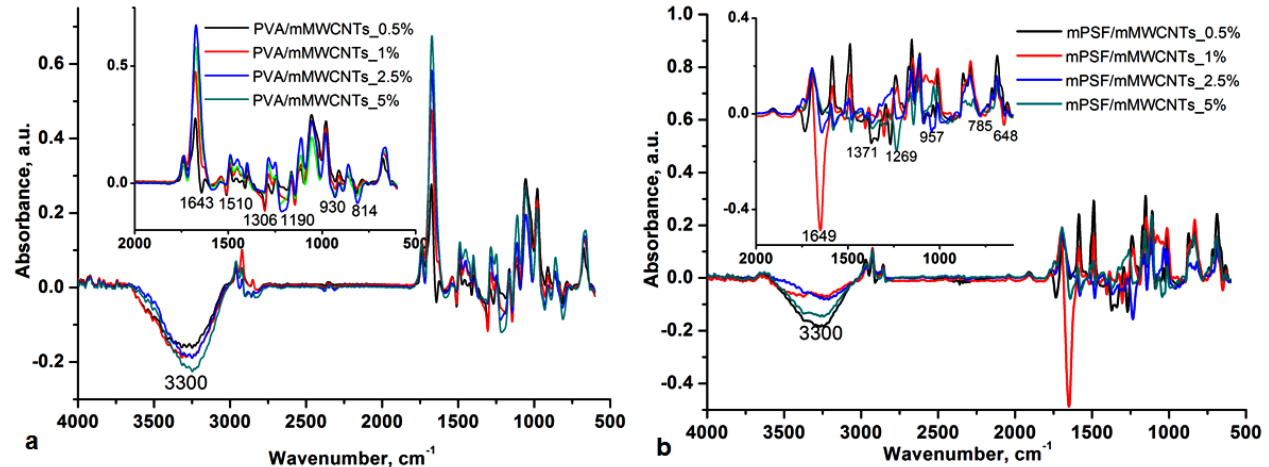
Figure 5. The subtracted IR spectra of PVA and PVA/mMWCNTs composites ( a ) and mPSF and mPSF/mMWCNTs composites ( b ).